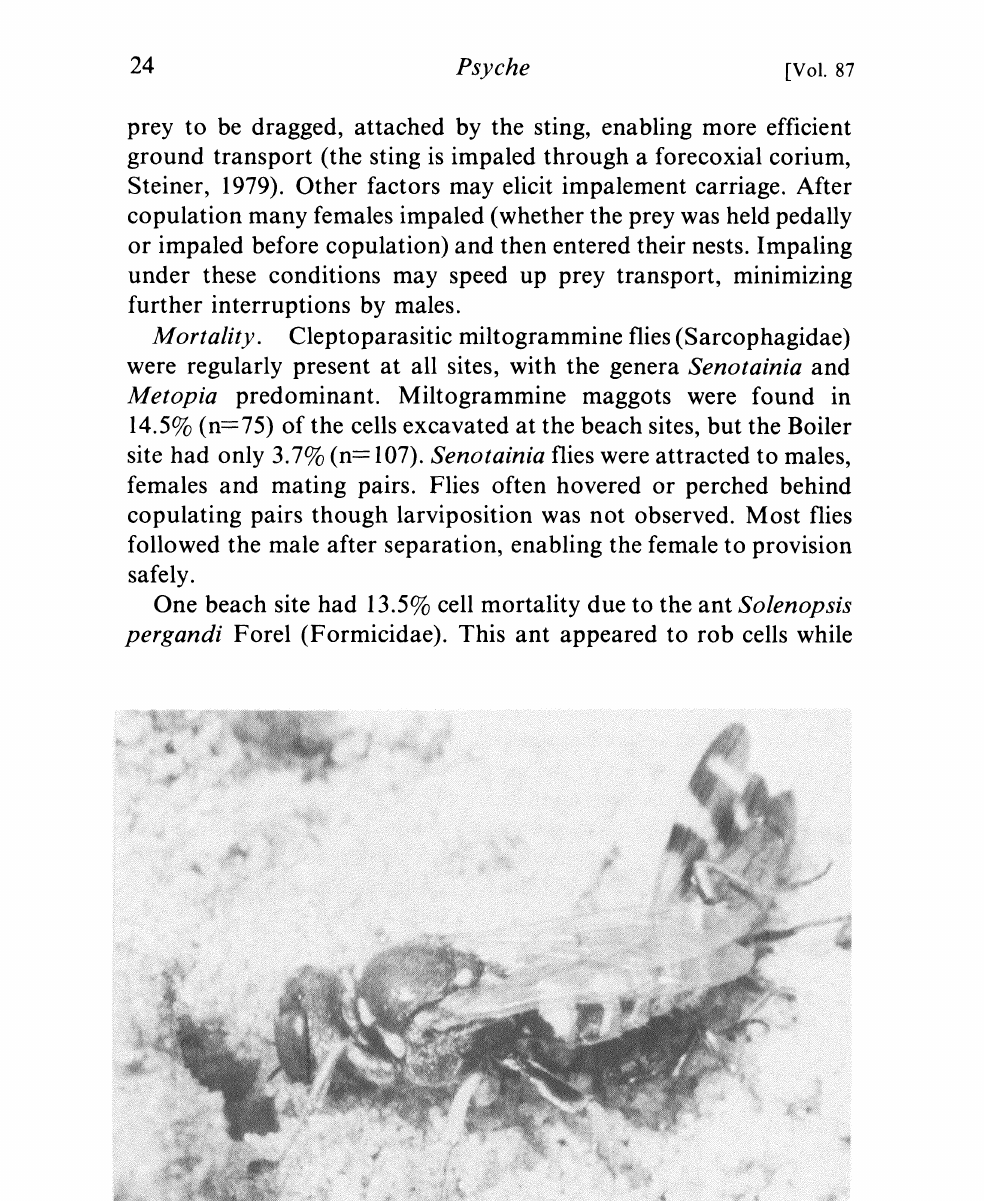
Figure 1. A female O. sericeus with a fly (Chaetopsis aenea) impaled on her sting. Nest entrance is at